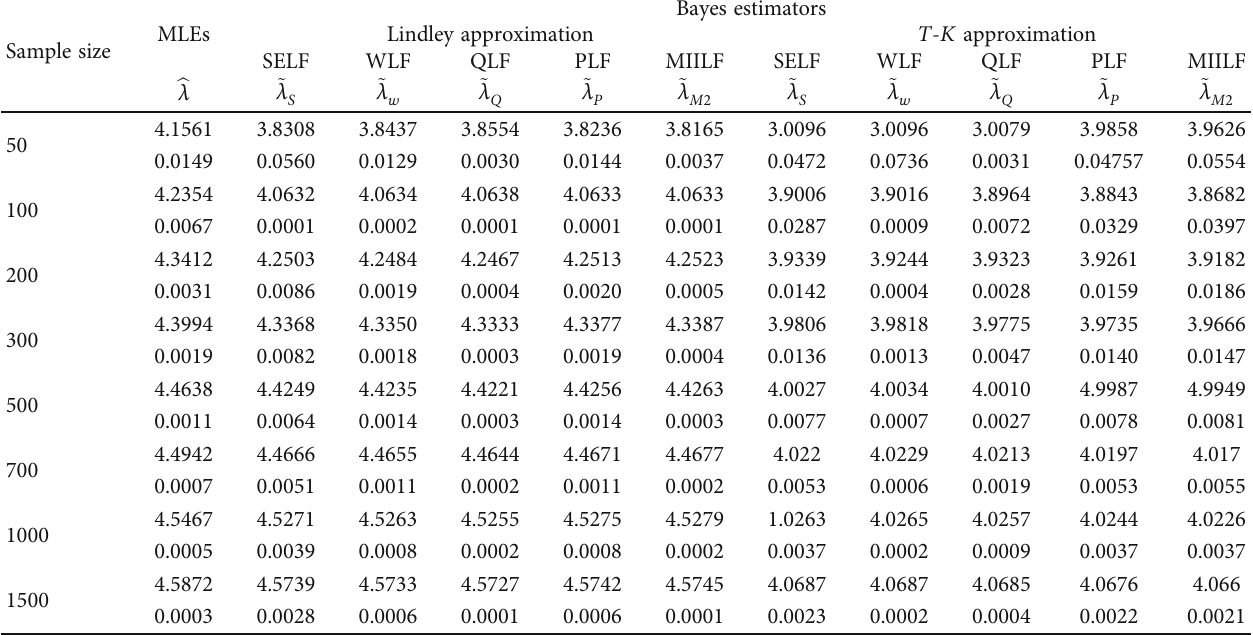
Table 2: The MLEs and Bayes estimators of λ with posterior risks under di ff erent loss functions.